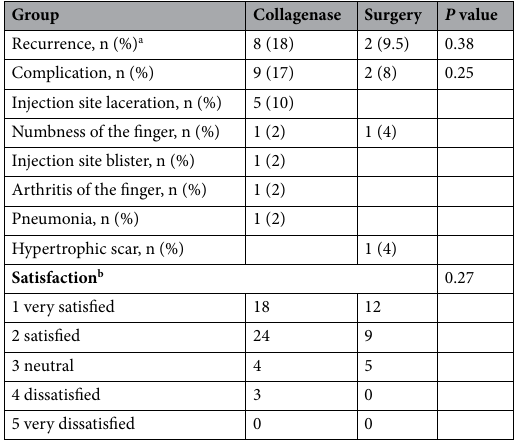
Table 4. Comparison of recurrence, complication, and satisfaction between Collagenase and Surgery groups. SD standard deviation. a The number of patients who were evaluated at 52 weeks in Collagenase and Surgery group was 45 and 21, respectively. b Data of 3 patients in collagenase group was absent.